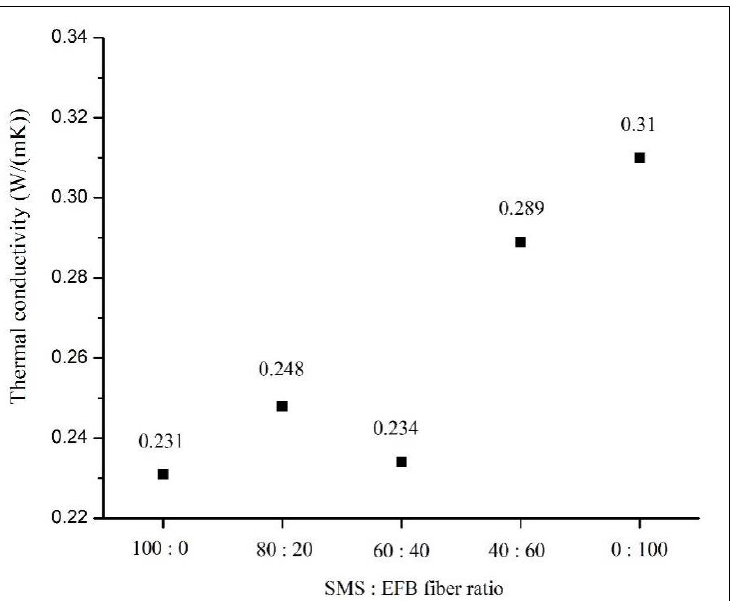
Figure 7. The effect of the SMS and EFB fiber ratio against the thermal conductivity of the sandwich composite panel.